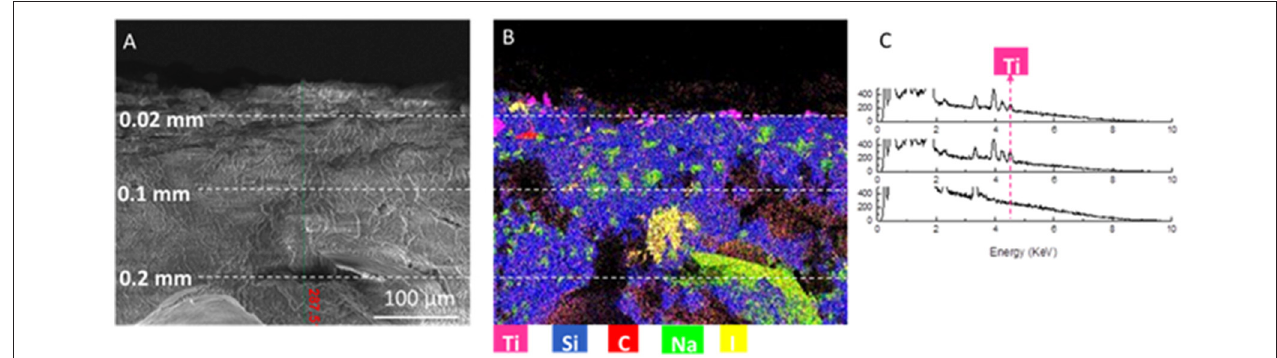
FIGURE 7 | (A) SEM image of the cross-section of the sample, at a depth of 0.28mm (B) corresponding elemental composition map with color code. Titanium signal is represented by magenta (C) corresponding EDS spectra at 0.02mm from surface, 0.04mm from surface and 0.1mm from surface.